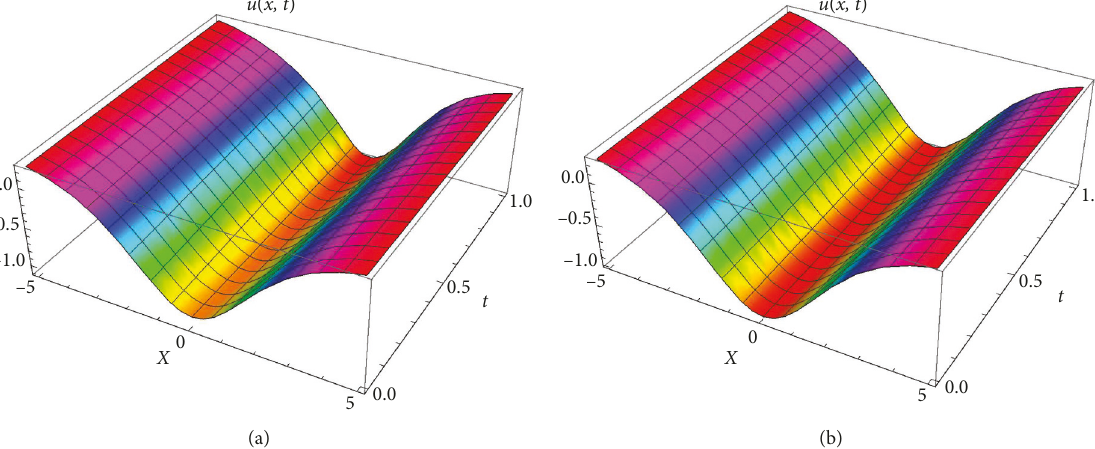
1. (a) Approximate solution. (cid:27)